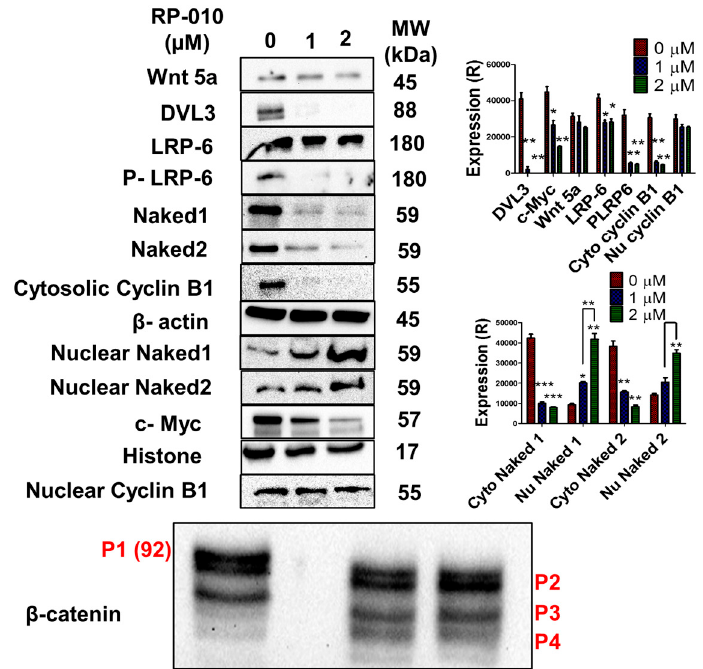
Figure 5. RP-010 induces significant changes in Wnt/ β -catenin signaling proteins. (Left) The effect of RP-010 (1 or 2 µM, after 24 h of incubation), or vehicle, on the expression levels of the following proteins: Wnt 5a, DVL3, LRP-6, P-LRP-6, cytosolic and nuclear Naked1 and 2, cytosolic and nuclear cyclin B, c-Myc, and β -catenin (bottom panel). β -actin and histone were used as reference proteins. The histograms (right panels) represent quantitative summaries of the results. (R) = relative. * p < 0.05, ** p < 0.01, *** p < 0.001.